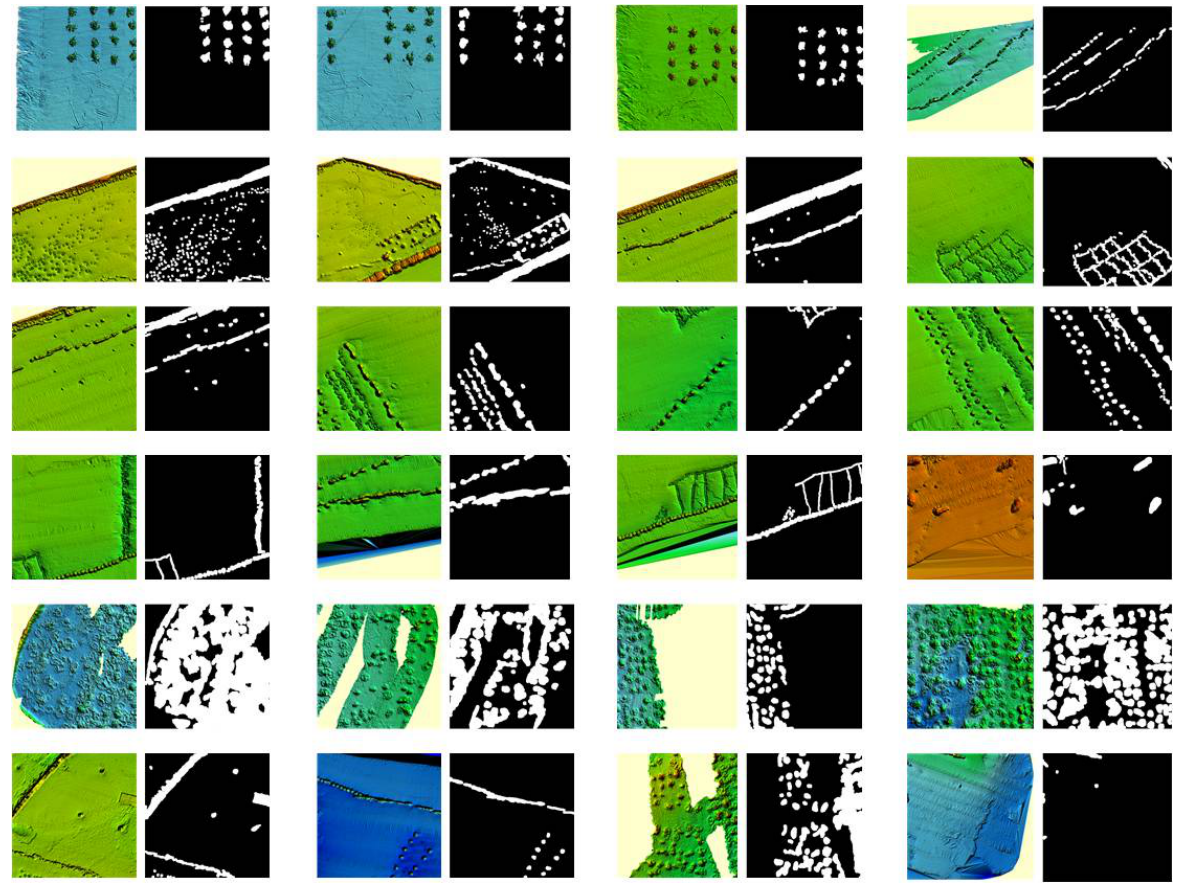
Figure 3. The samples of the images and annotations in the FIO-AR dataset.